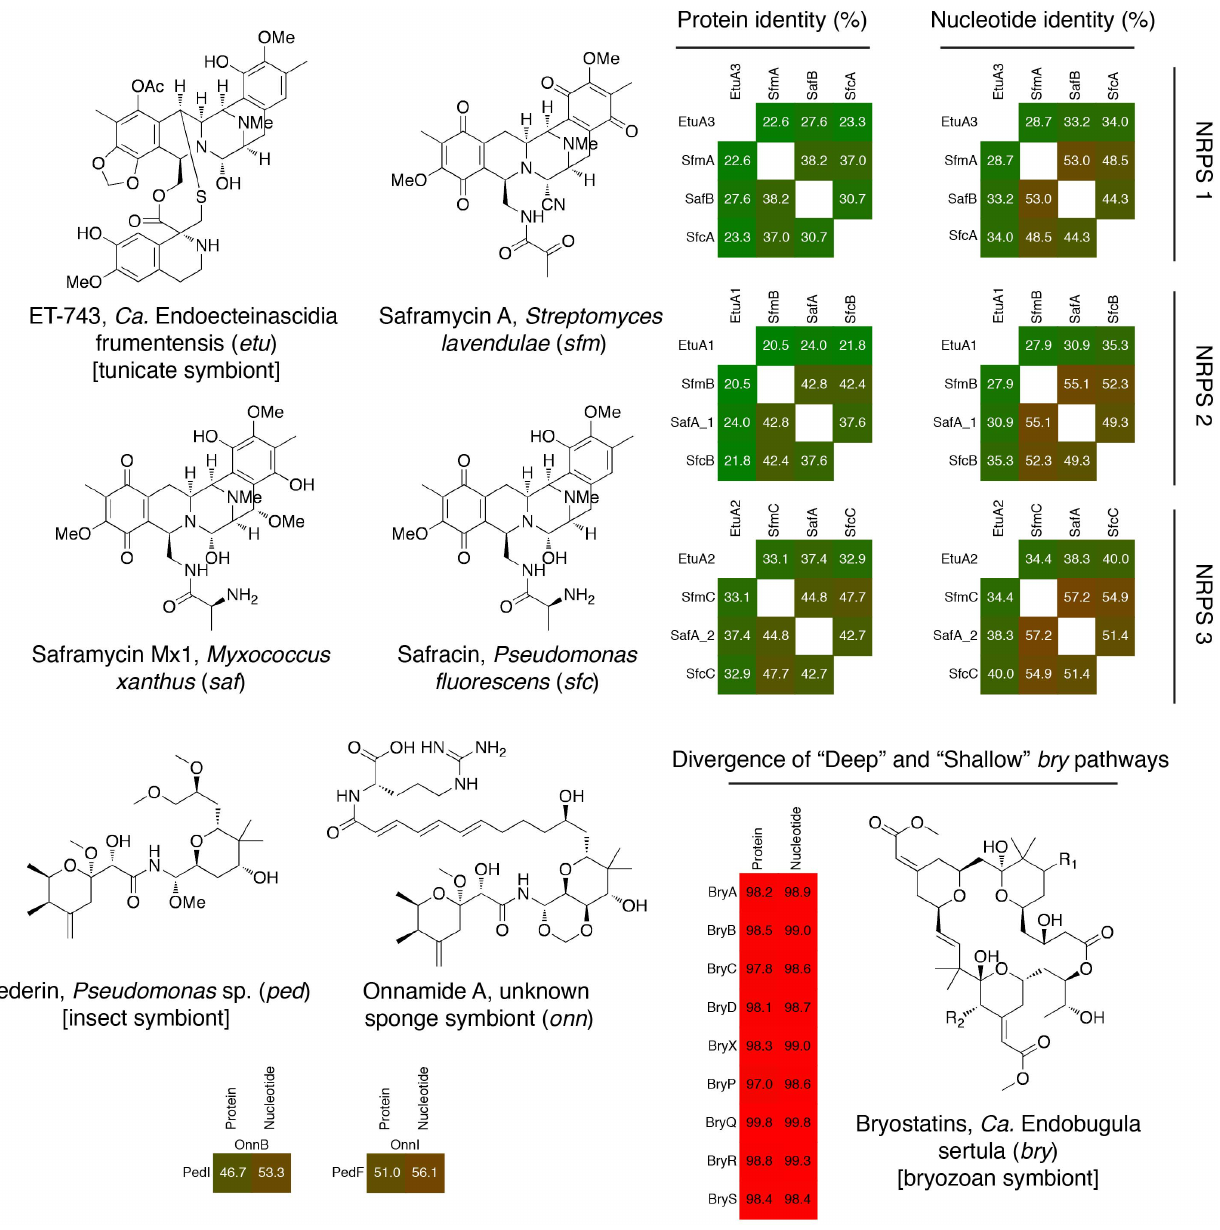
Figure 11. Divergence in biosynthetic pathways which produce natural products with related structures.